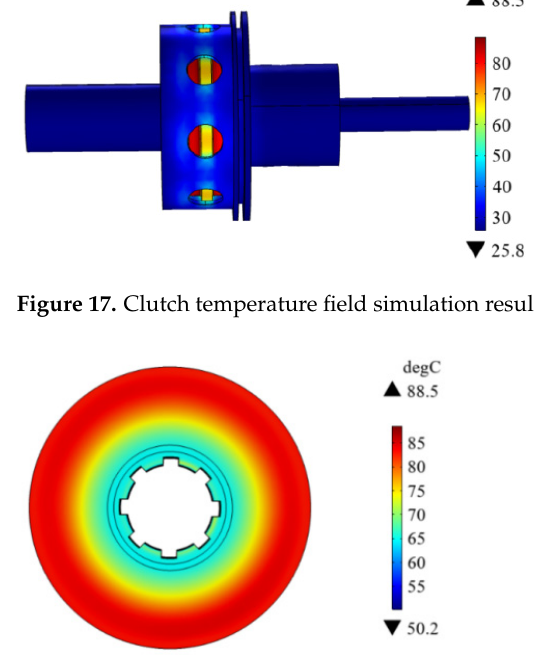
Figure 18. Simulation results of the clutch friction plate temperature field.